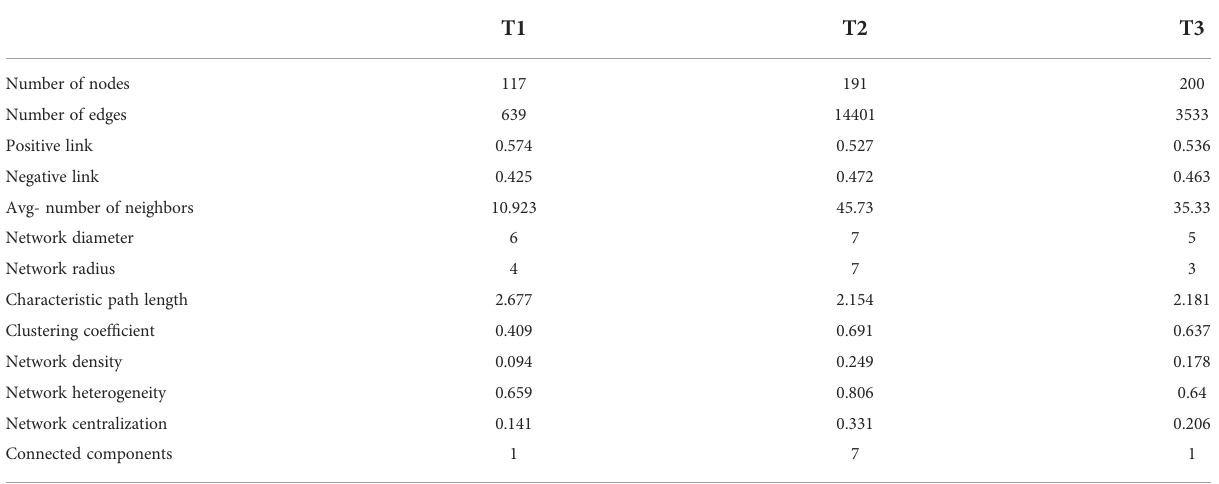
TABLE 1 Molecular ecological network properties of the three groups. T1 T2 T3